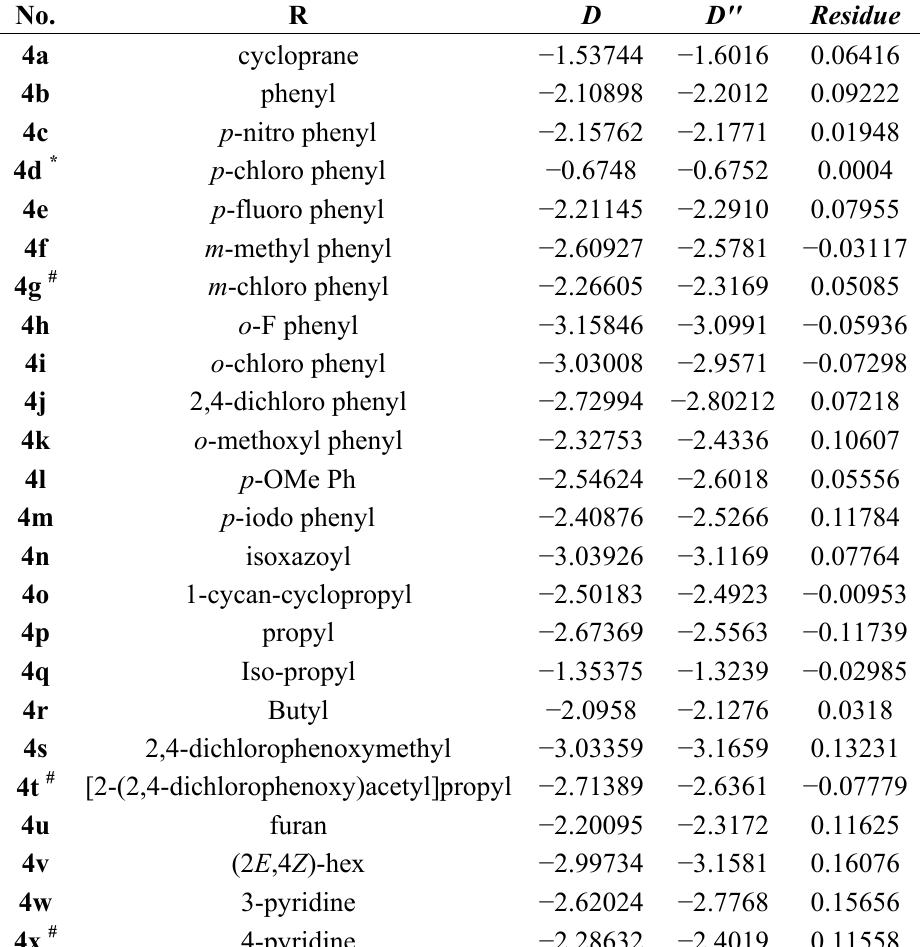
Table 3. The structures, activities and total score of